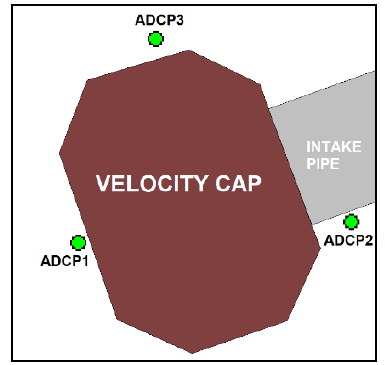
Figure 6. The measurement locations of ADCP1, ADCP2, and ADCP3.